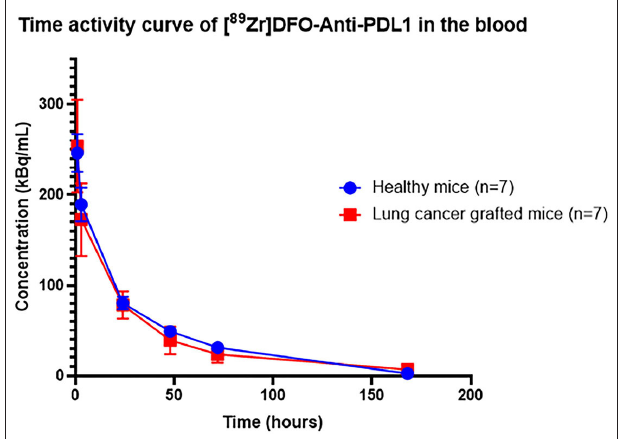
TABLE 1 | Blood PK parameters of healthy and lung cancer-grafted mice (NCA) estimated with the trapezoidal method. PK parameters